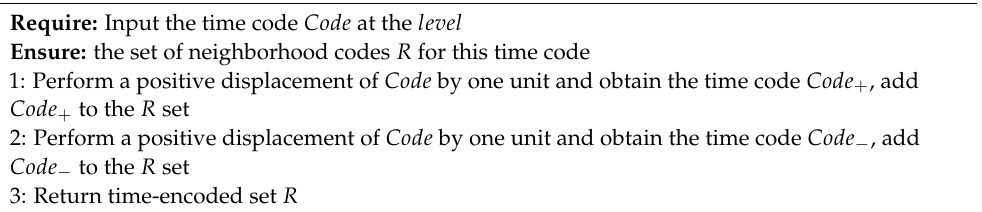
Algorithm 4: The calculation method of unit time neighborhood.